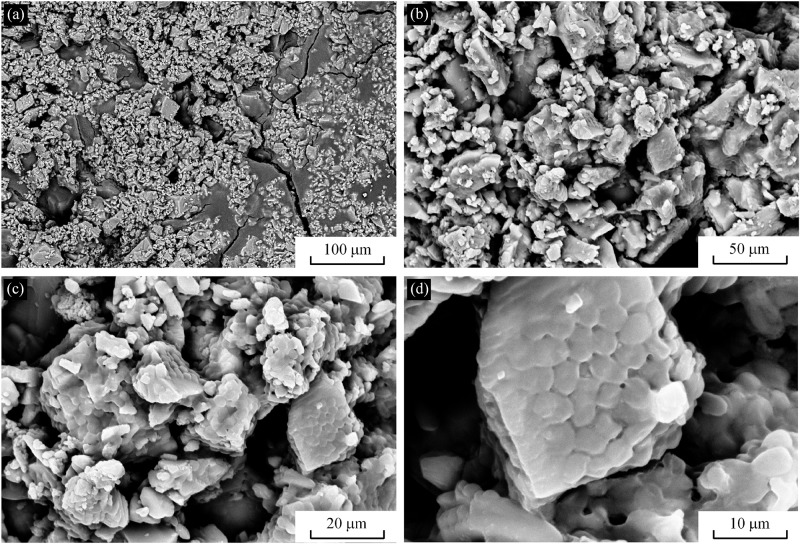
Scanning electron micrographs of MICP-treated samples.(a) and (b) are CaCO3 particles and the interlayer particles. (c) and (d) are CaCO3 particles.